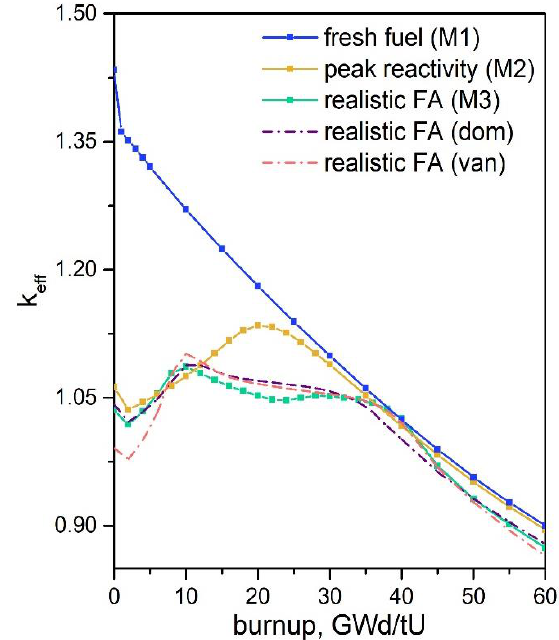
Figure 9. k eff as a function of burnup for the discussed 2D lattice models and 3D nodal code model of BWR assembly.